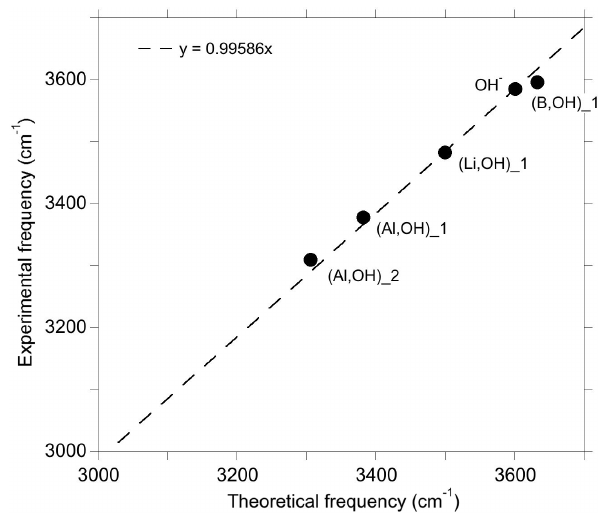
Figure 8. Experimental vs. theoretical OH-stretching frequencies of defect